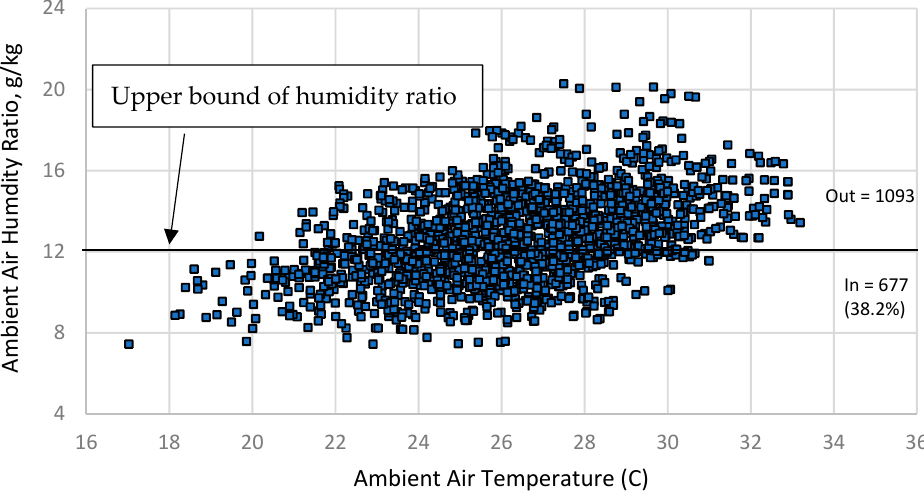
Figure 6. Plots of room temperature vs. humidity for Brisbane (Ambient condition).